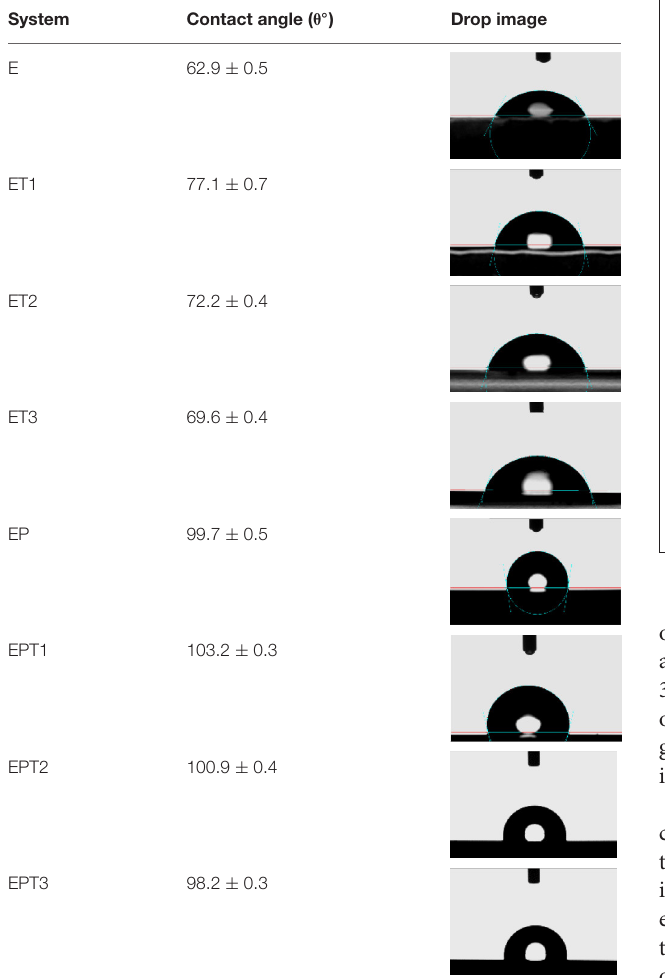
of epoxy coating and epoxy-TiO 2 nanocomposite coating against corrosion. After exposing the coated samples to 3.5% NaCl solution, the EIS measurements were carried out periodically and the collected results were presented immersion